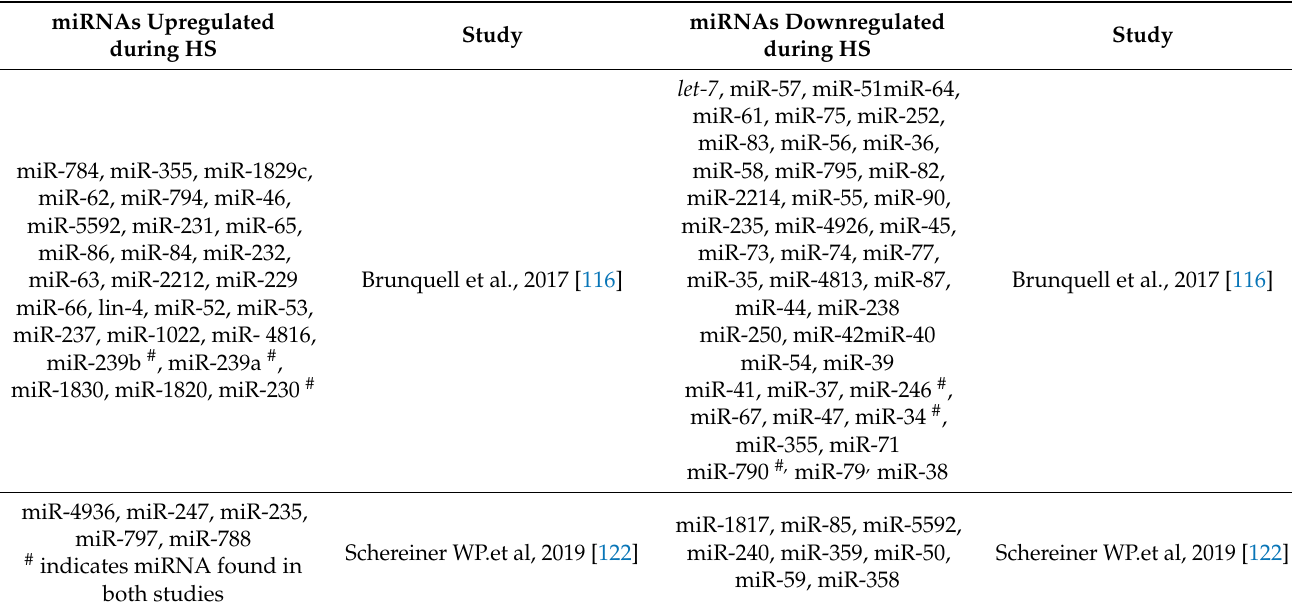
Table 1. miRNAs regulated during heat stress in C. elegans. # indicates miRNA found in both